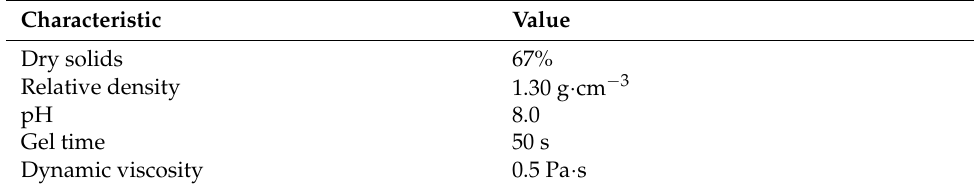
Table 1. Selected properties of UF resin used in this work.